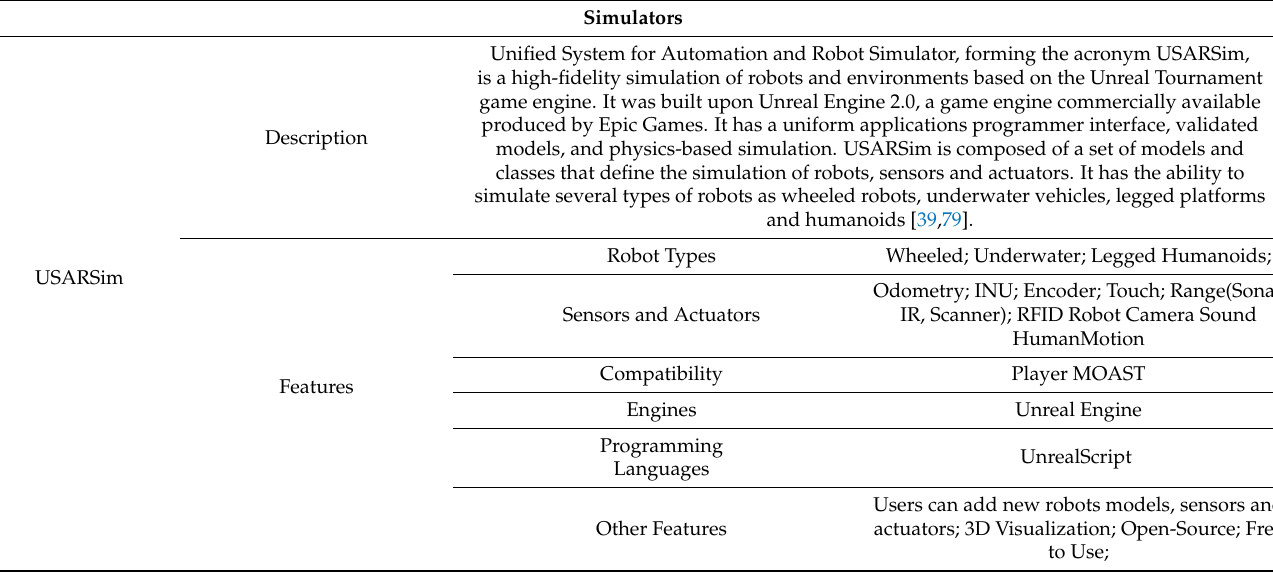
Table 5. Simulators